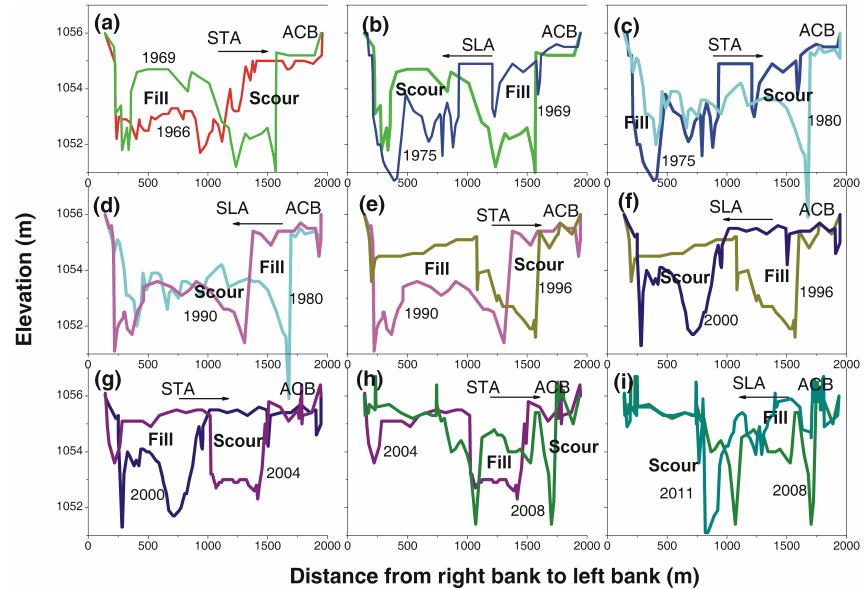
Figure 7. Changes of the cross section of C8 from 1966 to 2011. ACB is the aeolian sand-covered bank, STA is the channel shift towards the ACB and SLA is the channel shift leaving from the ACB. (a) , (c) , (e) , (g) and (h) indicate that when the channel shifts toward the ACB, the sand dunes are eroded and the aeolian sands are transported towards the channel centre and the point bars are then formed on the opposite bank. (b) , (d) , (f) , and (i) show that as the channel moves away from the ACB, the point bars are formed between the main channel and the ACB, which in turn block wind-blown sand entering into the channel.